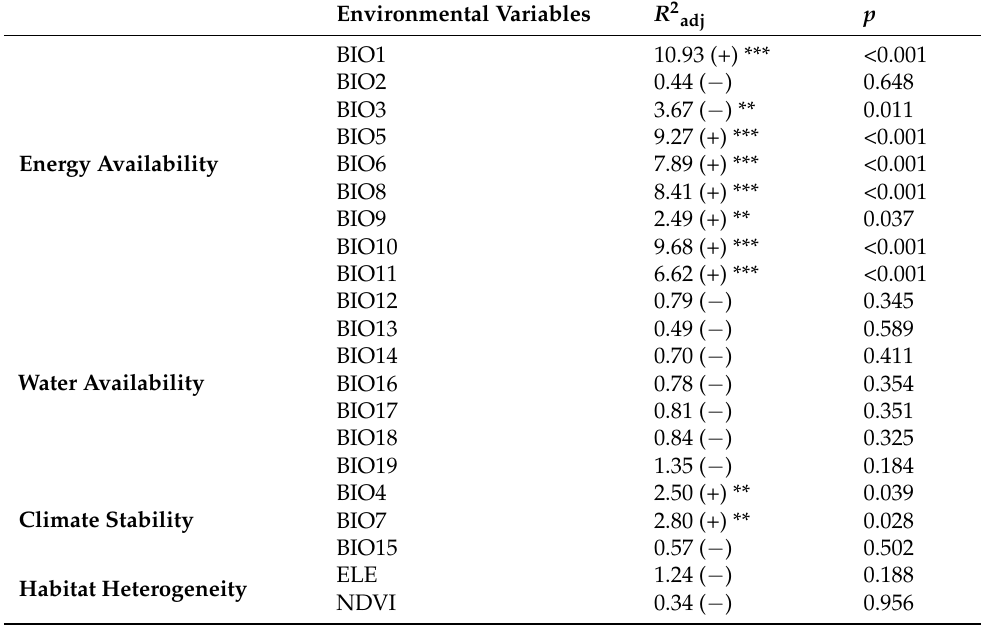
Table 1. The generalized linear models (GLMs) used to evaluate the explanatory power of each environmental variable for species richness ( R 2 adj , %). Environmental Variables R 2 adj p